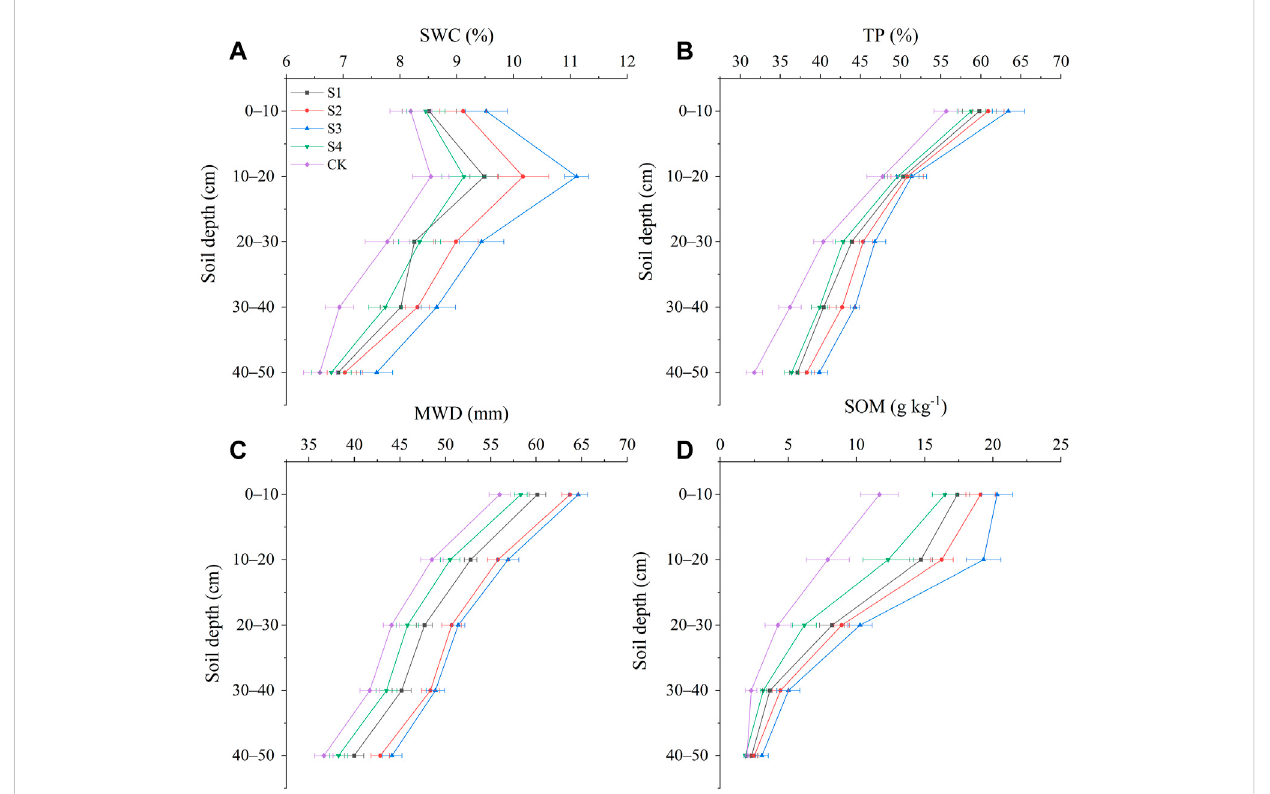
FIGURE 4 Changes in soil properties with soil depth for different stump heights. (A) Soil water content, (B) soil porosity, (C) mean weight diameter, and (D) soil organic